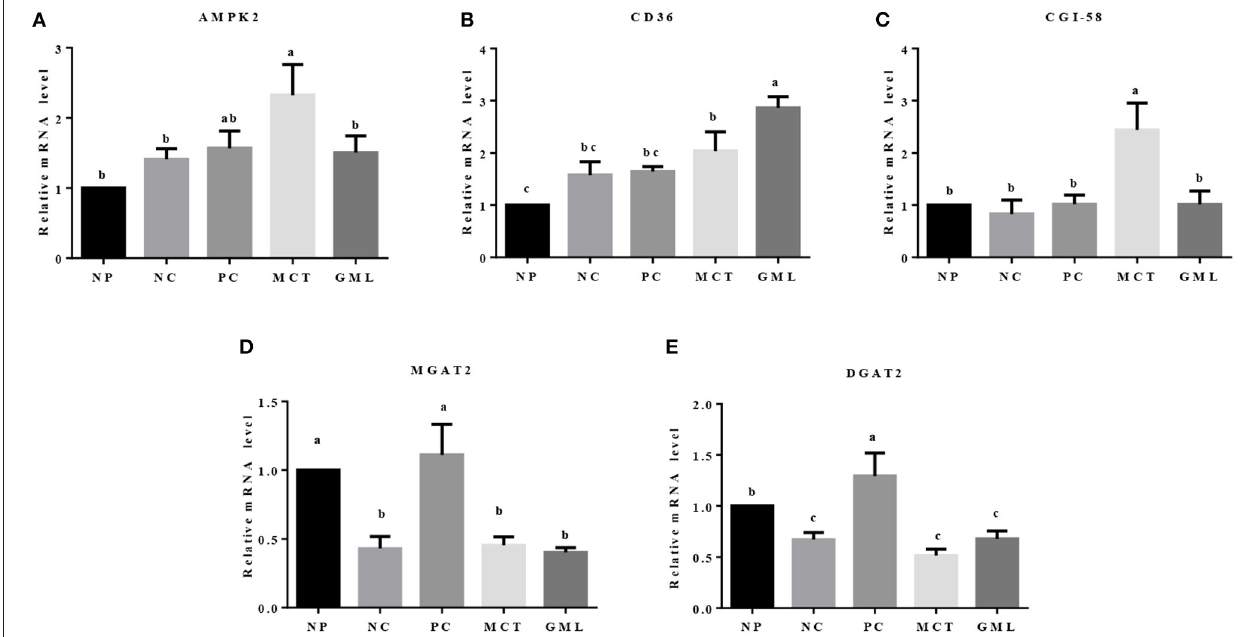
FIGURE 5 | (A–E) The mRNA expressions of genes associated with lipid sensing in the liver. a − c Mean values sharing different superscripts within a row differ ( P < 0.05). Values are the mean ± SEM, n = 6. NP, normal protein basal diet no antibiotics included; NC, low-protein basal diet no antibiotics included; PC, low-protein